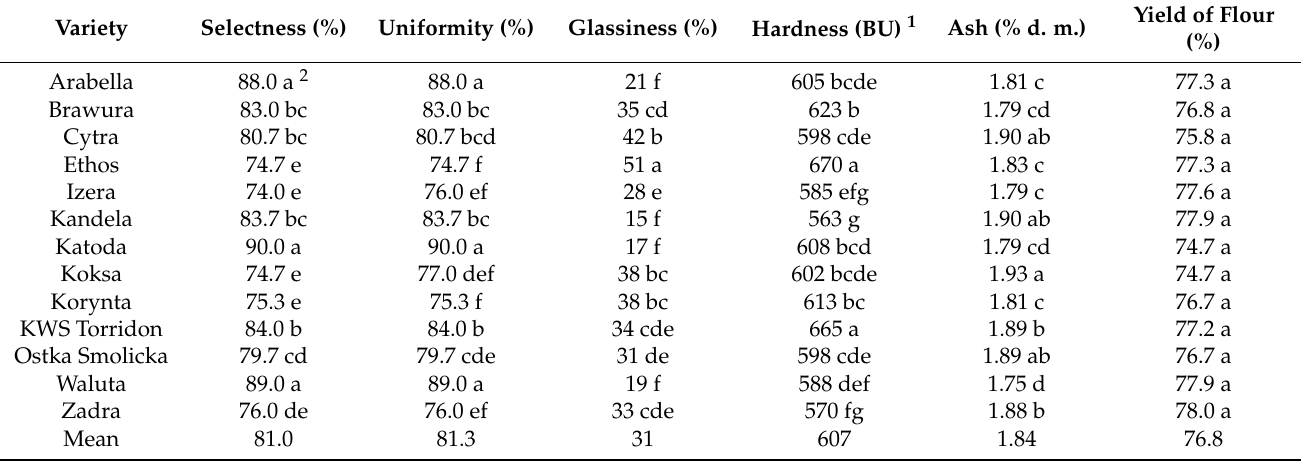
Table 7. Results of the assessment of grain milling value (averages over